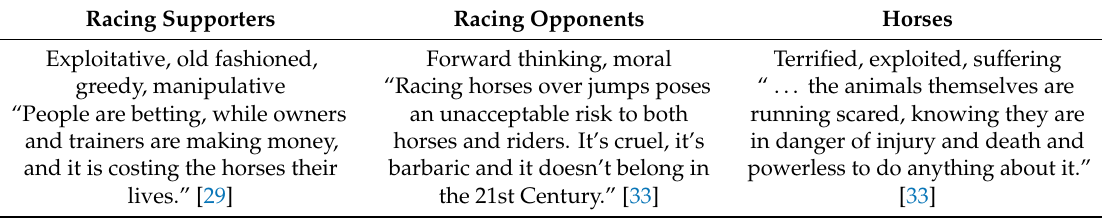
Table 4. Attributes of protagonists in eight articles opposed to New Zealand jumps racing published between May 2016–August 2018. Racing